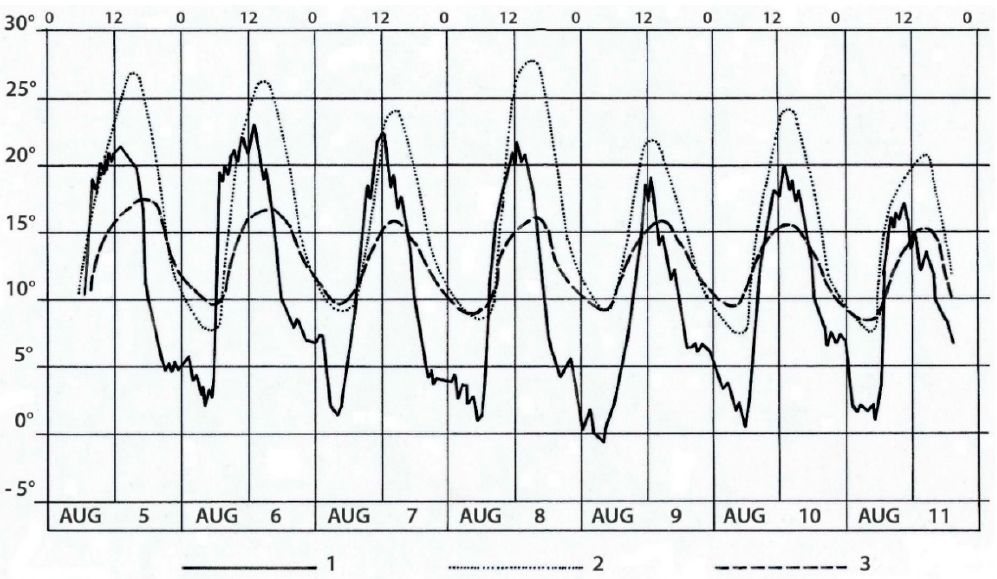
Figure 11. Daily temperature (°C) fluctuations measured with mechanical thermographs at ~2335 m, 5–11 August 2002. Key . 1. Air temperature (+10 cm); 2. Bare-soil temperature (5 cm depth); 3. Soil (5 cm depth) under canopy of an isolated, ~125-cm-high, 223-cm-wide k ū paoa; thermal sensor was buried ~23 cm away from the shrub stem.